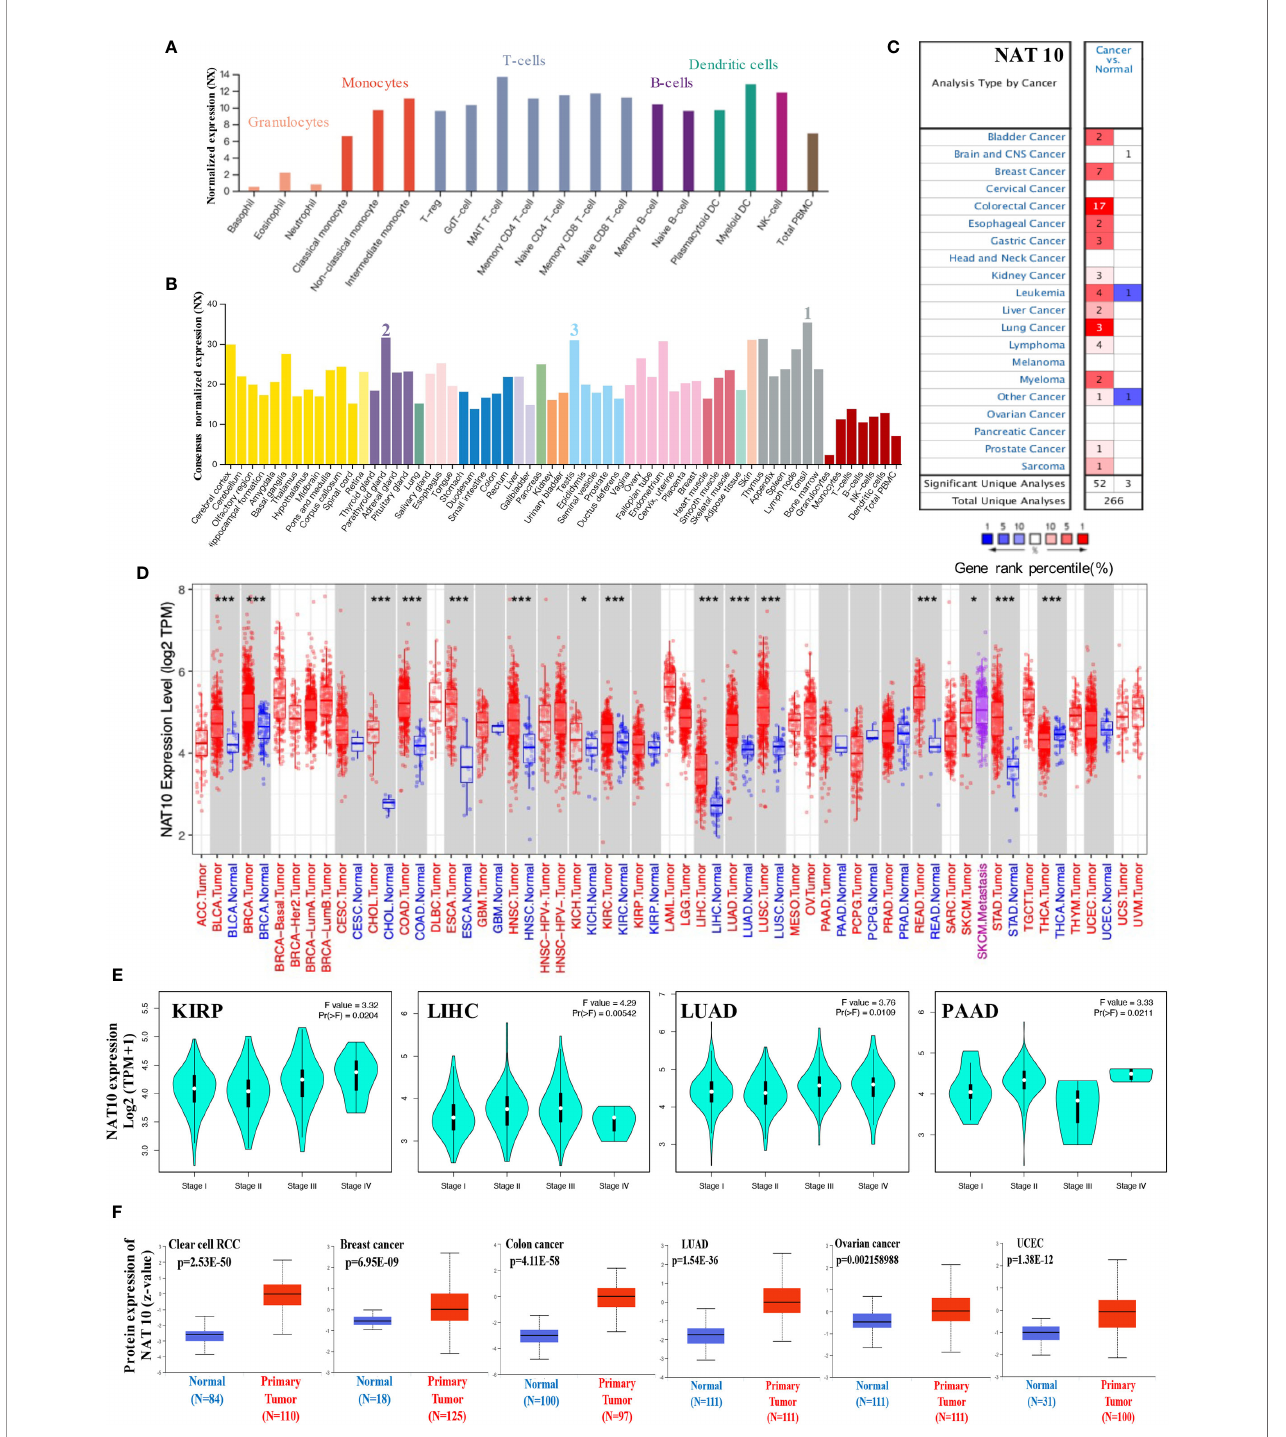
FIGURE 1 | Expression levels of NAT10 in different tumors and pathological stages. (A, B) We analyzed the expression of NAT10 gene in different blood cells using the consensus datasets of HPA, Monaco and Schmiedel (A) or in different tissues using the consensus datasets of HPA, GTEx and FANTOM5. (C) Increased or decreased expression of NAT10 in datasets for different cancer tissues, compared with normal tissues from the Oncomine database. The number in each cell is the size of the dataset. (D) The expression status of NAT10 gene in different cancers or speci fi c cancer subtypes was determined by TIMER2. (E) Based on the TCGA data, the expression of NAT10 was analyzed by the main pathological stages (stage I, stage II, stage III and stage IV) of KIRP, LIHC, LUAD and PAAD. Log2 (TPM+1) was applied for log-scale. (F) The expression of NAT10 total protein between normal tissue and primary tissue of breast cancer, ovarian cancer, colon cancer, clear cell RCC and UCEC was analyzed based on the CPTAC dataset. *P < 0.05, ***P <